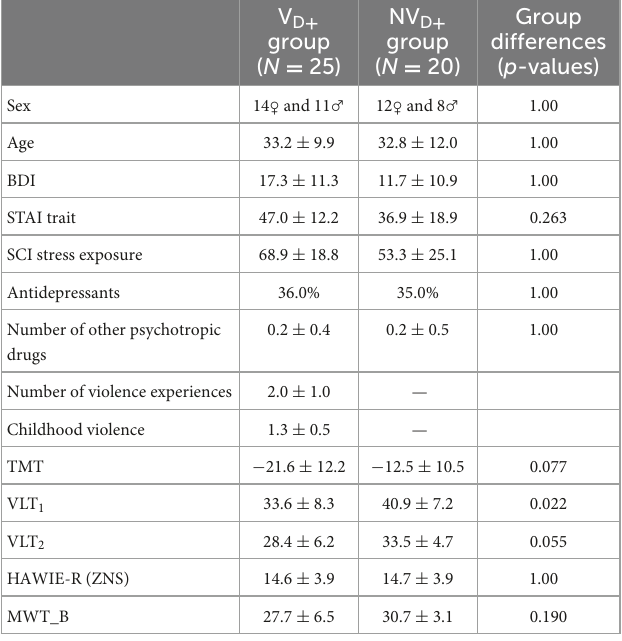
TABLE 3 Sample characteristics for victims of violence (V D + ) and non-victims (NV D + ) with a current diagnosis: Binary variables (sex, MINI diagnosis, and antidepressants): Statistical comparison of groups performed via chi-square test of independence; Continuous variables: mean ± standard deviation, statistical comparison of groups performed via independent two-sample t -test for normally distributed features [SCI stress exposure, TMT, VLT 2 , HAWIE-R (ZNS)] and Mann Whitney U -test for non-parametric cases (the